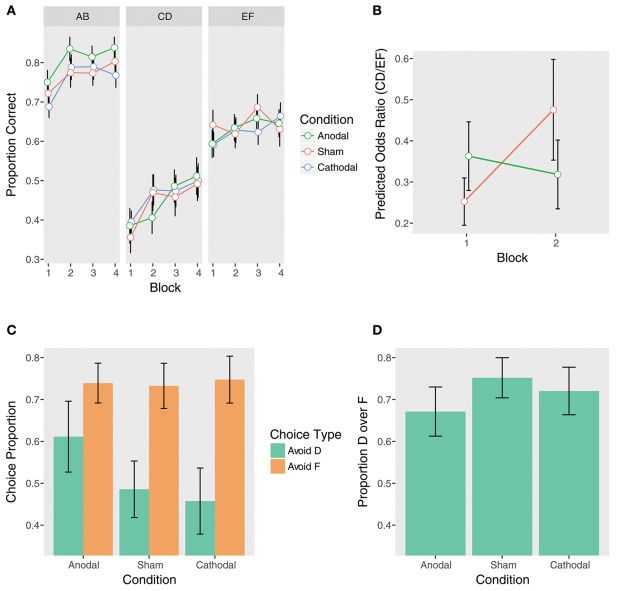
Performance at training (top) and test (bottom) by tDCS stimulation condition. (A) Training phase performance by trial type. (B) The effect of anodal stimulation on instructed reinforcement learning. Points are predicted odds ratios for the CD/EF contrast by block and condition. This contrast reflects performance on CD controlling for performance on EF, giving a purer measure of the effect of instructions on choice. Lines represent the two-way Trial Type x Block interactions within each condition. Error bars are standard errors of the parameter estimates. While the sham group demonstrated significant learning away from the instructions from Block 1 to Block 2, the anodal group did not, and this interaction was significant (see section tDCS: Training Phase: Instructed Learning). (C) Avoid-D/Avoid-F. (D) DF trials.